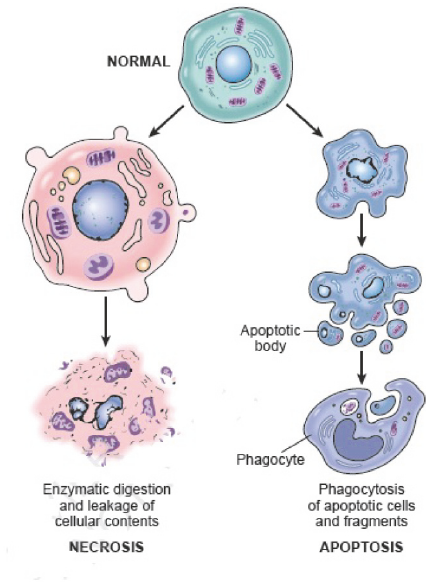
Figure 2: Difference between necrosis and